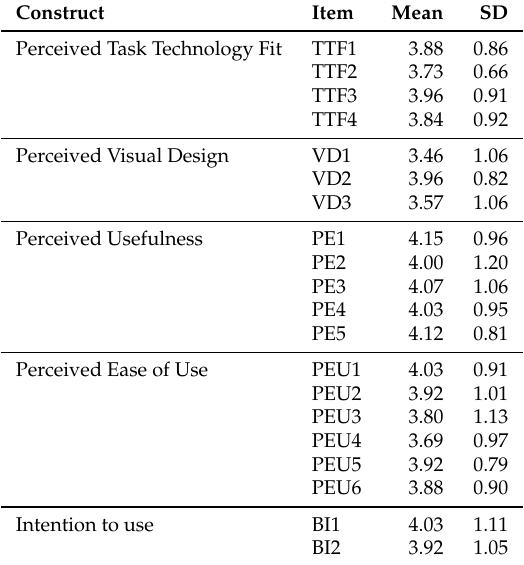
Table 3. Means and standard deviations of technology acceptance model (TAM) measures (N = 26).